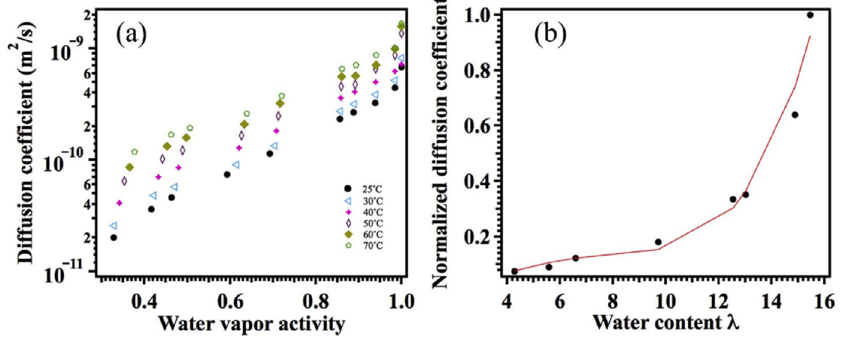
Figure 40. ( a ) Self-diffusion coefficient of water in the OH − form of Tokuyama A201 as a function of the water vapor activity at 25 °C to 70 °C; ( b ) normalized water diffusion coefficient in the OH − form membrane as a function of the water content λ . Reprinted with permission from Ref. [78]. Copyright © 2022 Published by Elsevier B.V.